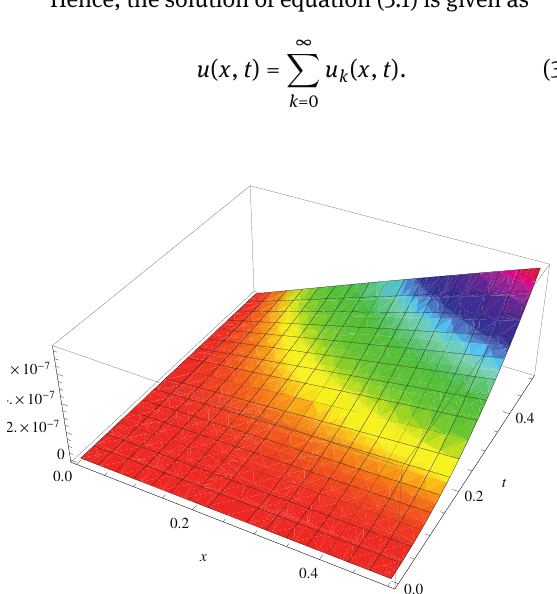
Fig. 2: Plot of absolute error E 4 = | u ( x , t ) − u 4 ( x , t ) | .